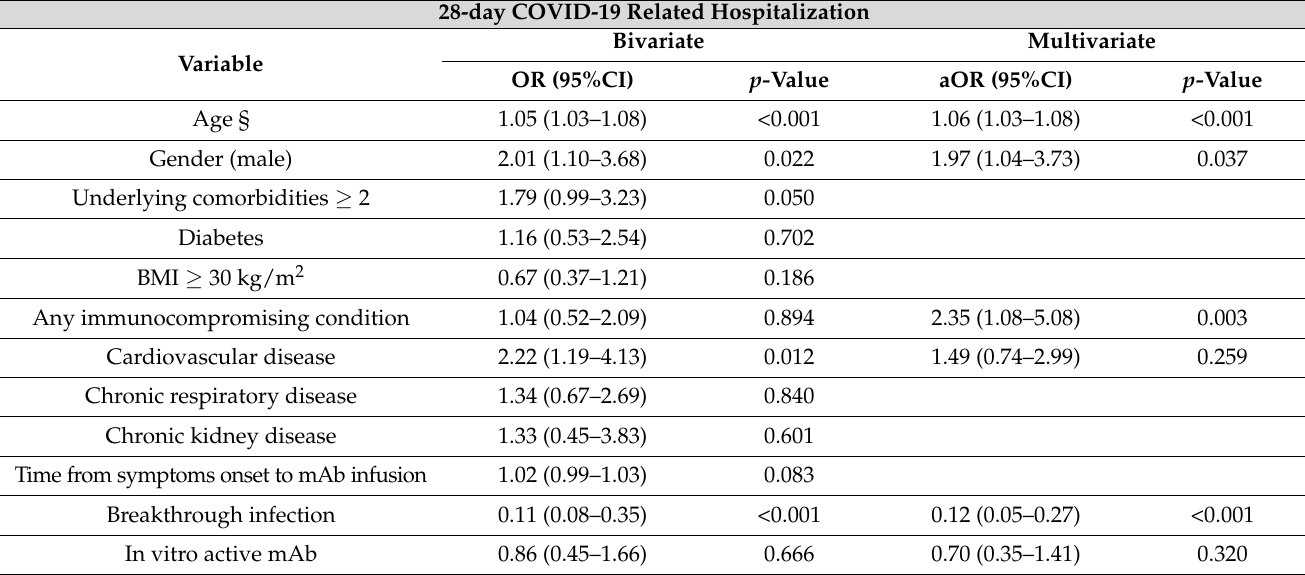
Table 3. Predictors related to 28-day COVID-19 related hospitalization on the regression model.